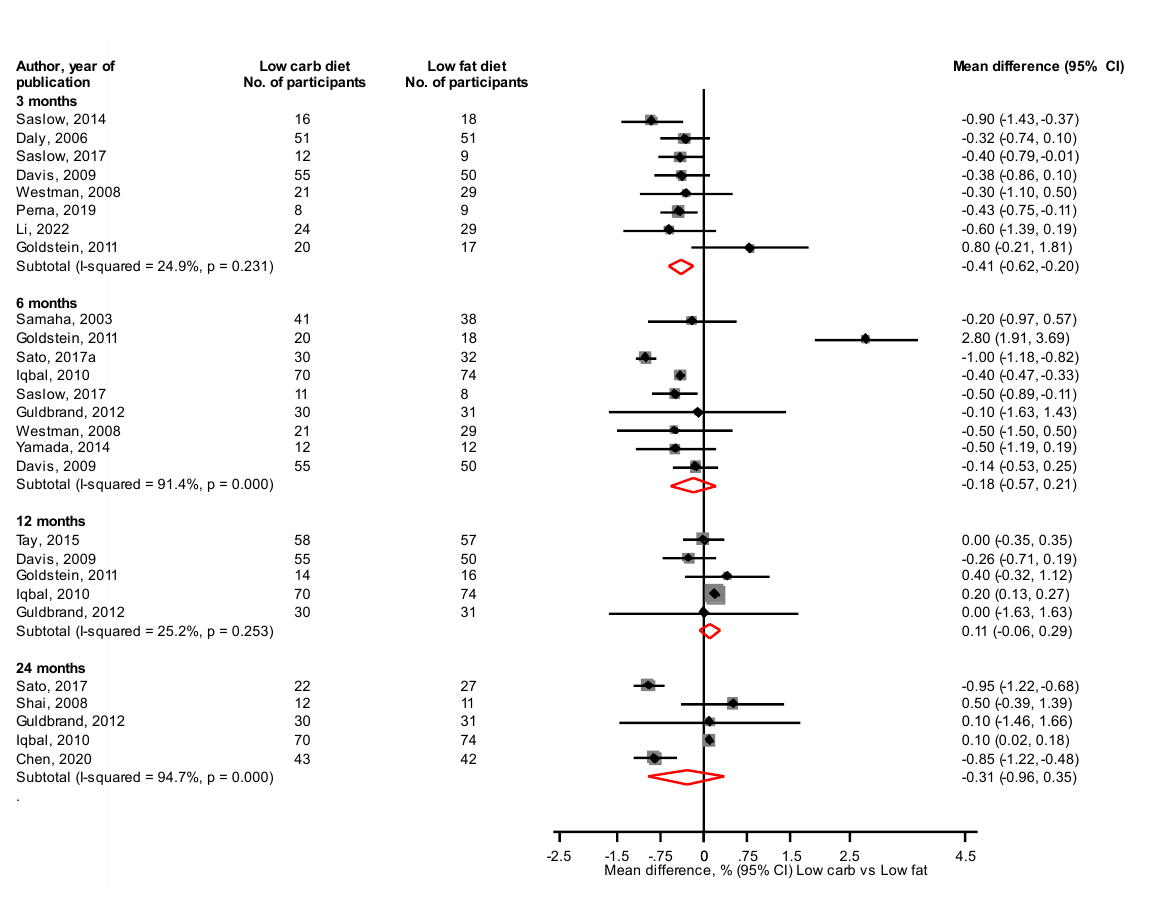
Figure 3. Low carbohydrate versus low fat diet and HbA1c levels [31 – 36,41,42,42,44,46,47,50 – 52,54].